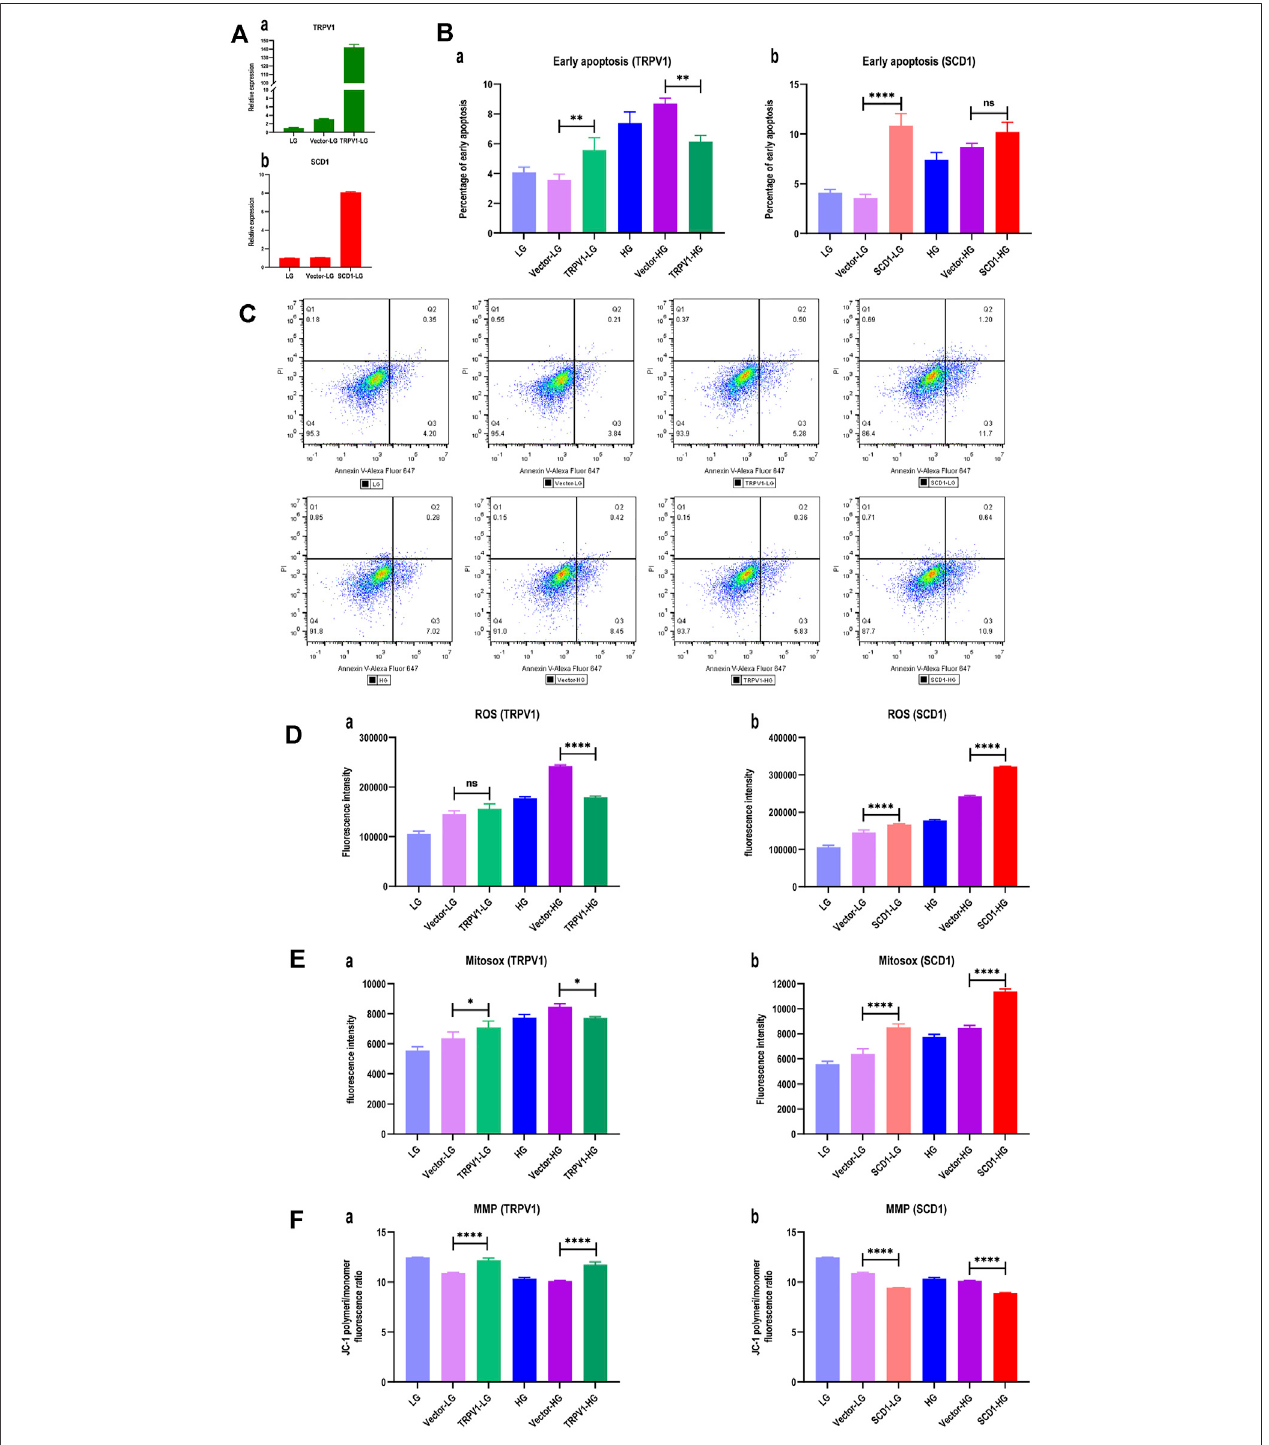
FIGURE 6 | Overexpressions of TRPV1 and SCD1 in HK2 cells: LG, low glucose; Vector-LG, vector plasmid transfected low glucose; TRPV1-LG, TRPV1 plasmid transfectedlowglucose;SCD1-LG,SCD1plasmidtransfectedlowglucose;HG,highglucose;Vector-HG,vectorplasmidtransfectedhighglucose;TRPV1-HG,TRPV1 plasmid transfected high glucose; SCD1-HG, SCD1 plasmid transfected high glucose. (A) Gene expression after transfecting TRPV1 and SCD1 : (a) gene expression of TRPV1 ; (b) gene expression of SCD1 . (B) Histogram of percentage of early apoptosis of HK2 cells: (a) percentage of early apoptosis of HK2 cells with overexpressionof TRPV1 ;(b)percentageofearlyapoptosisofHK2cellswithoverexpressionof SCD1 .ns,nostatisticaldifference;**, p < 0.01;***, p < 0.001. (C) Dotplot